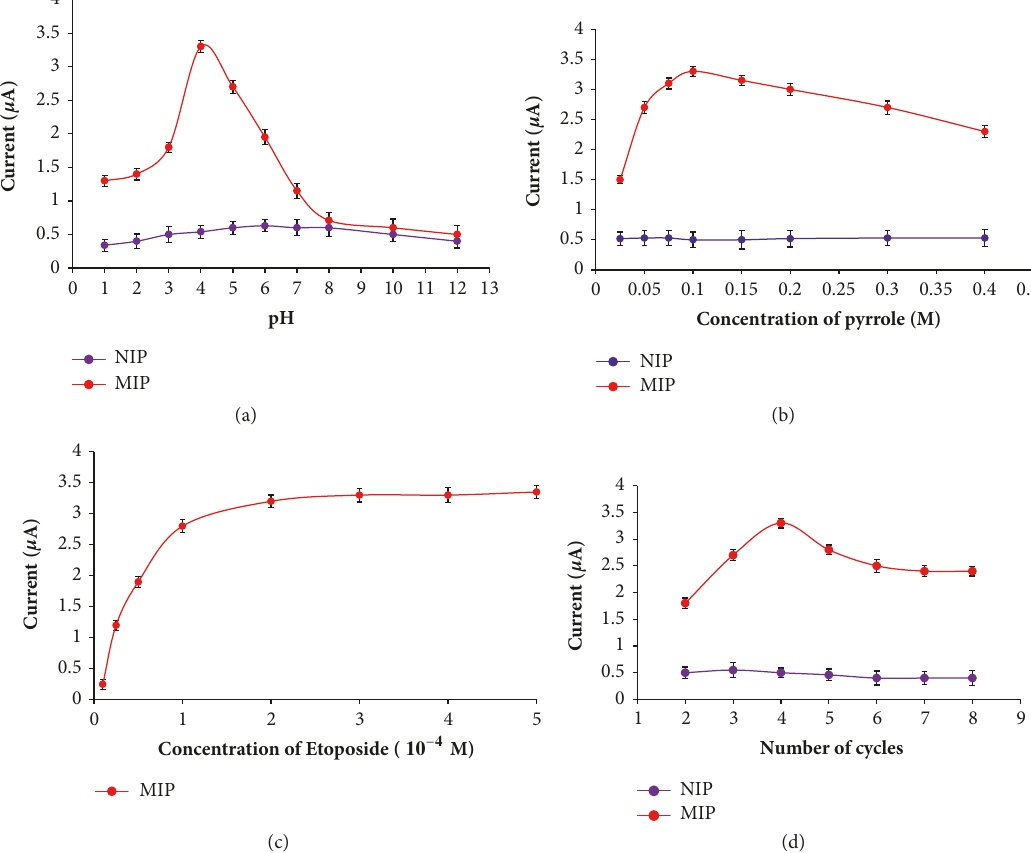
Figure 2: (a) The effect of pH of Britton-Robinson buffer solution; (b) pyrrole concentration; (c) ETP concentration; and (d) the number of cycles on MIP and NIP GCE sensitivity. The electroanalytical signal was measured through DPV response to 5.0 × 10 −6 M ETP in BRB solution (pH 4.0). Error bars represent the standard deviation of three independent